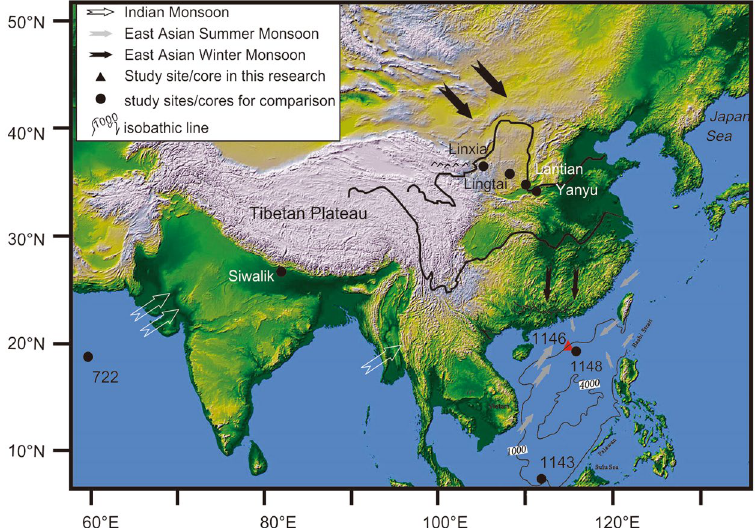
Figure 1. Map showing location of ODP Site 1146 and other important sites mentioned in the paper. The upper left panel contains the legend for the map. Ocean core locations ODP Site 1081 (South Atlantic, 19°37.2 ′ S, 11°19.2 ′ E, 793.8 m water depth), ODP site 717 (Bengal Fan, 0°56 ′ S, 81°23 ′ E, 4734.7 m water depth) and DSDP Leg 10 Site 94 (Gulf of Mexico, 24°20 ′ N, 88°28.2 ′ W, 1793 m water depth) mentioned in the text of the paper are not shown. The map was generated specifically for this paper using the ETOPO5 gridded elevation dataset (Version ETOPO5, http://www.ngdc.noaa.gov/mgg/global/etopo5.HTML) and Coreldraw (Version Coreldraw X7, http://www.corel.com/cn); no copyright problems are